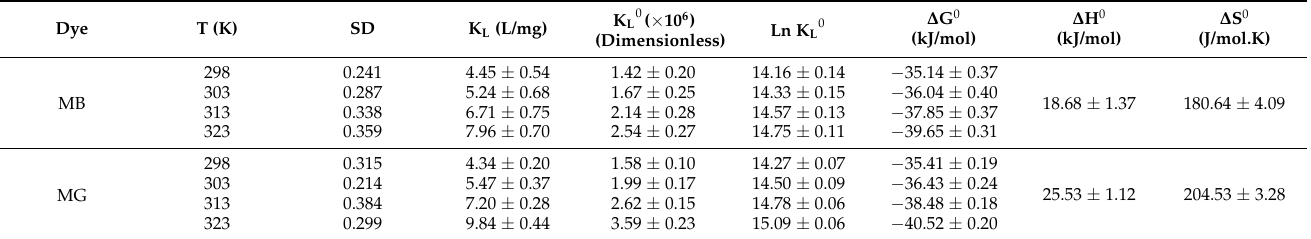
Table 6. Thermodynamic parameters for adsorption of MG and MB onto